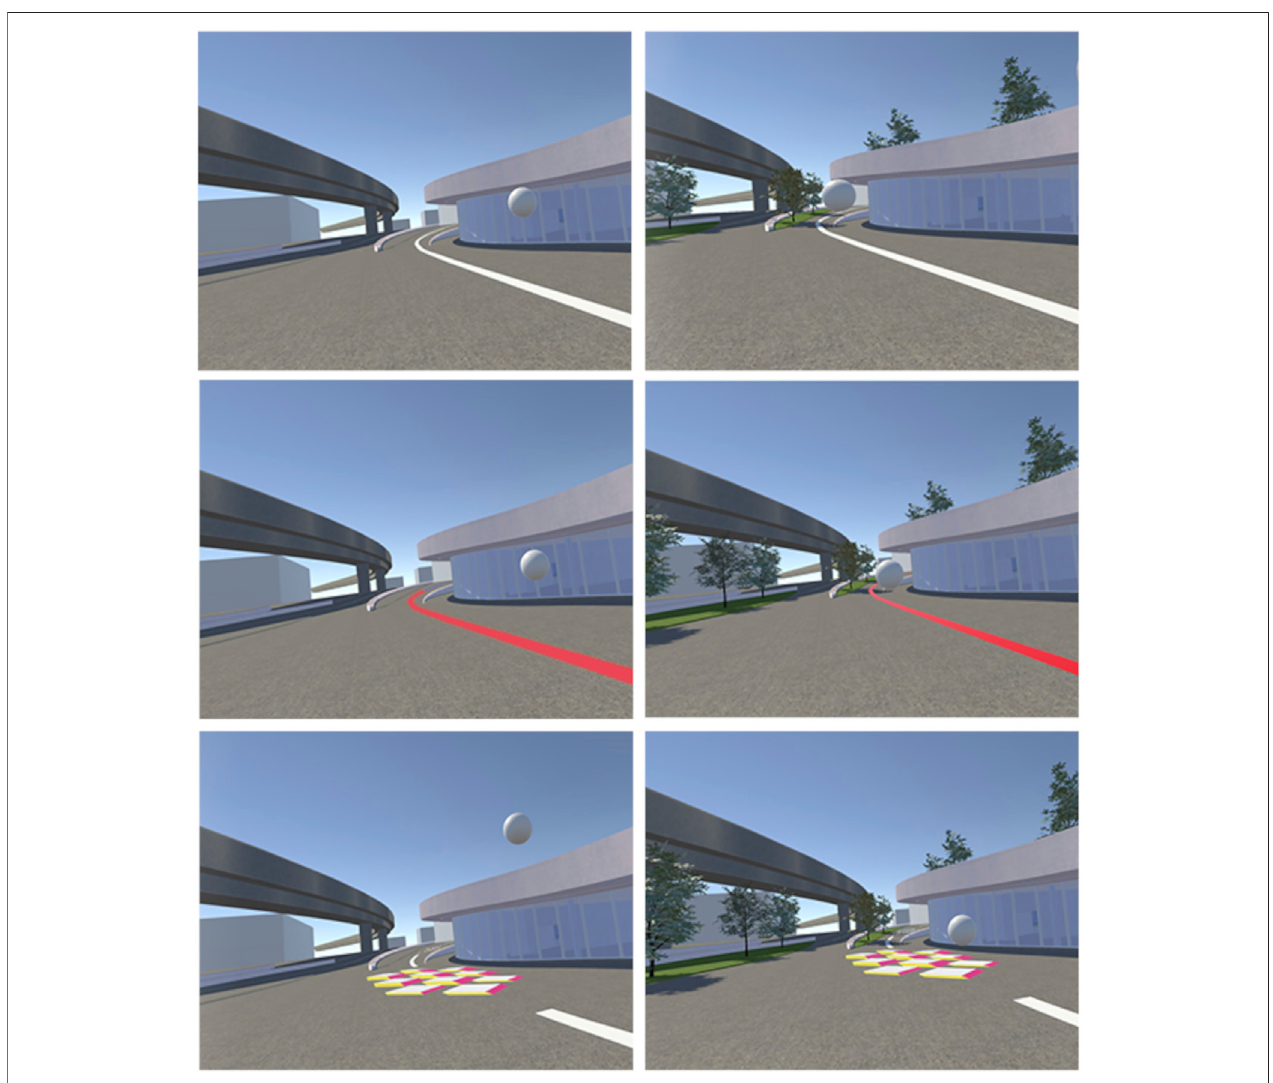
FIGURE 2 | Illustration of the six virtual environments that were created using UNITY. The protocol provided the means to evaluate the impact of color visual environments on user experience. Top row = no color fl oor marking; Middle row = RGB color lines (red, blue, green); Bottom row = RGB colors embedded in playful